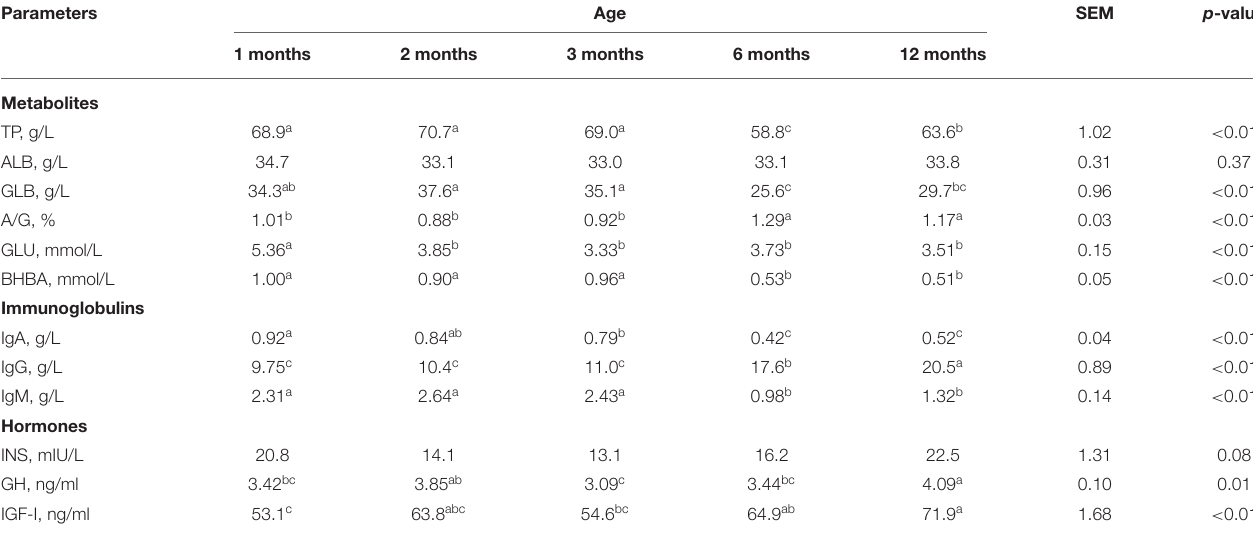
TABLE 2 | Blood parameters of goats from 1 to 12 months of age ( n = 6 per group). Parameters Age SEM p -value